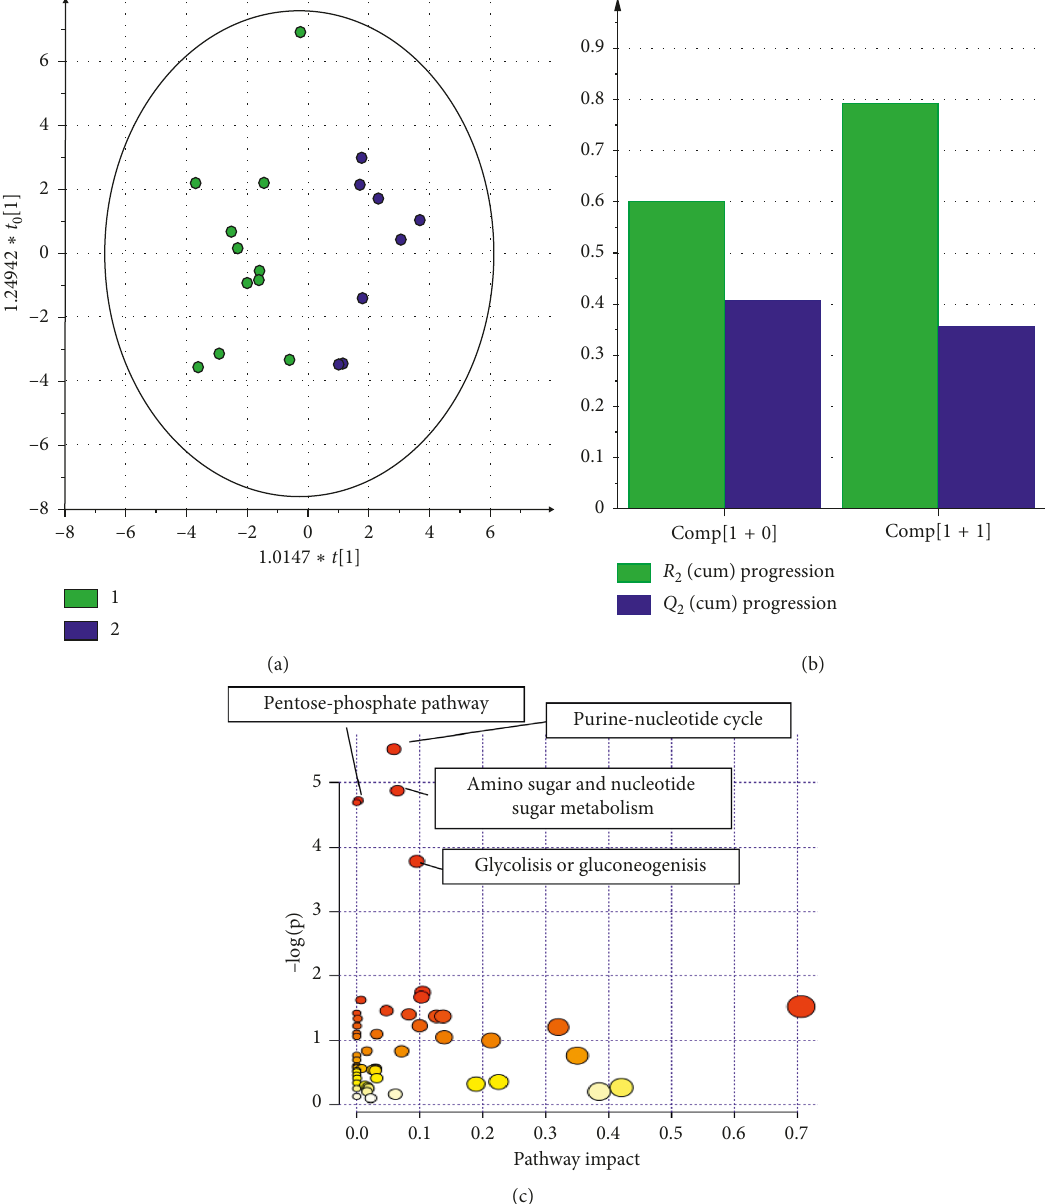
Figure 1: (a) The OPLS-DA model indicated a clear separation between the groups; (b) cross validation ( R 2 � 0.793 Q 2 � 0.358); (c) metabolic hubs mainly affected in CAA